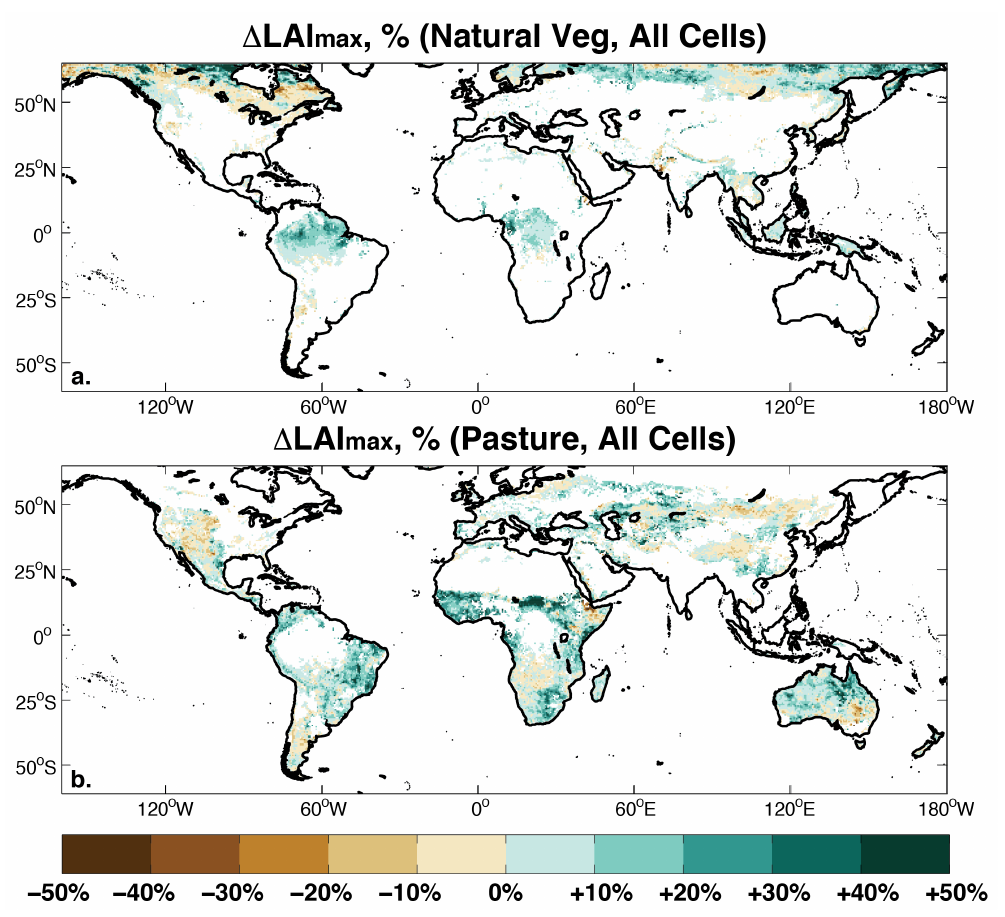
Figure 6. Percent change in LAImax (1982–2008) for all ( a ) natural ( < 10% pasture cover) and ( b ) pasture ( ≥ 10% pasture cover) vegetated cells, with no significance masking. Cells with ≥ 30% cultivated crop fractions have been masked out.